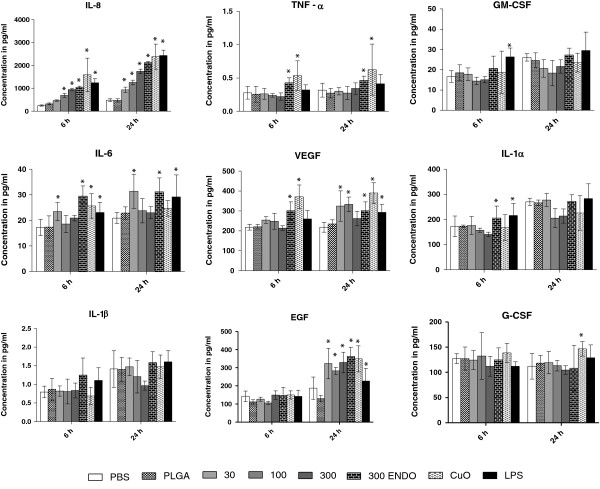
Levels of various cytokines at 6 and 24 h after nanoparticle treatment in primary small airway epithelial cells. The concentrations of various cytokines measured in cell culture supernatant after nanoparticle treatment at different time points. All values are in picograms and represented as mean± SE.